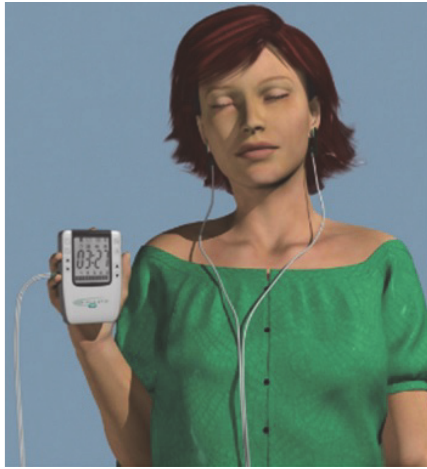
Figure 1: Alpha-Stim CES